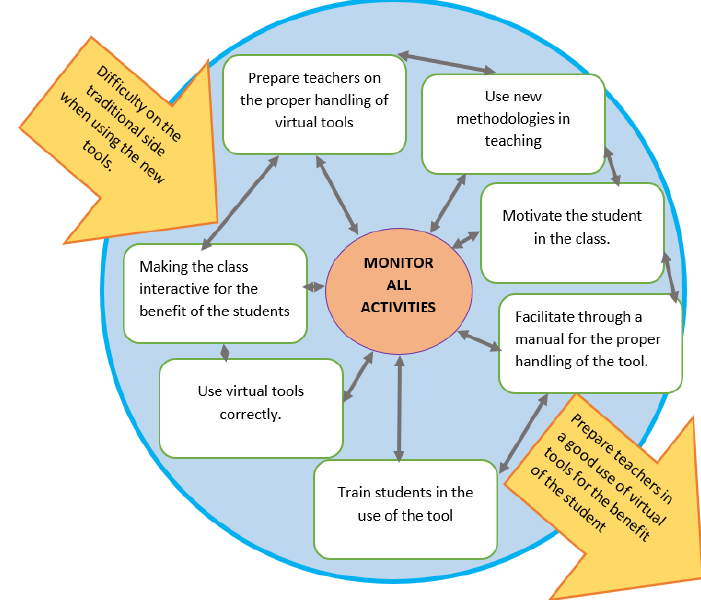
Fig. 16. Confirmed and validated conceptual